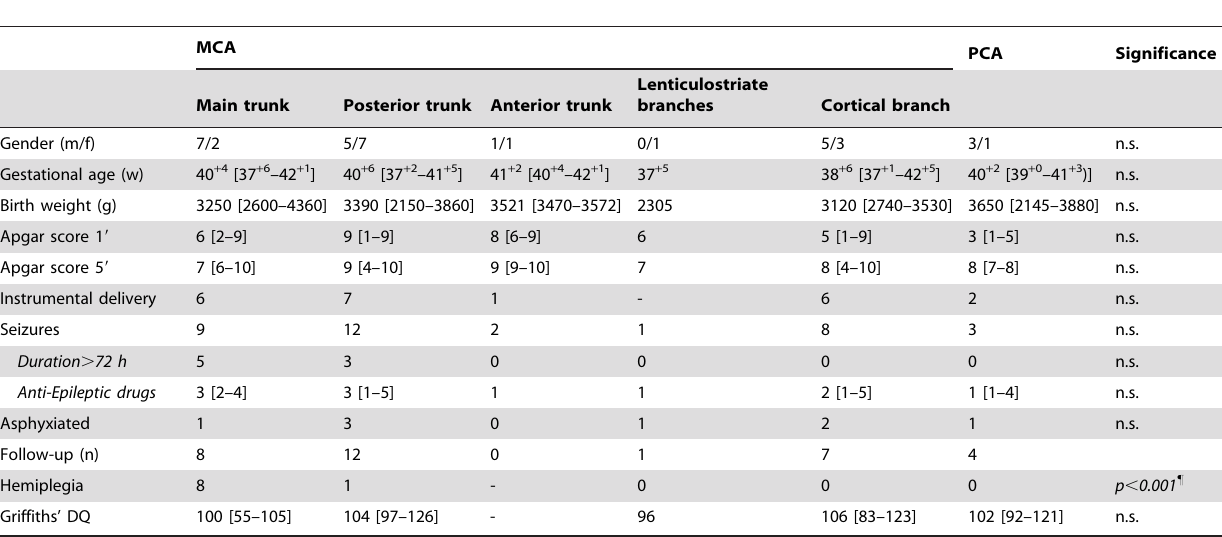
Table 1. Clinical characteristics of studied infants reported as median and [range].